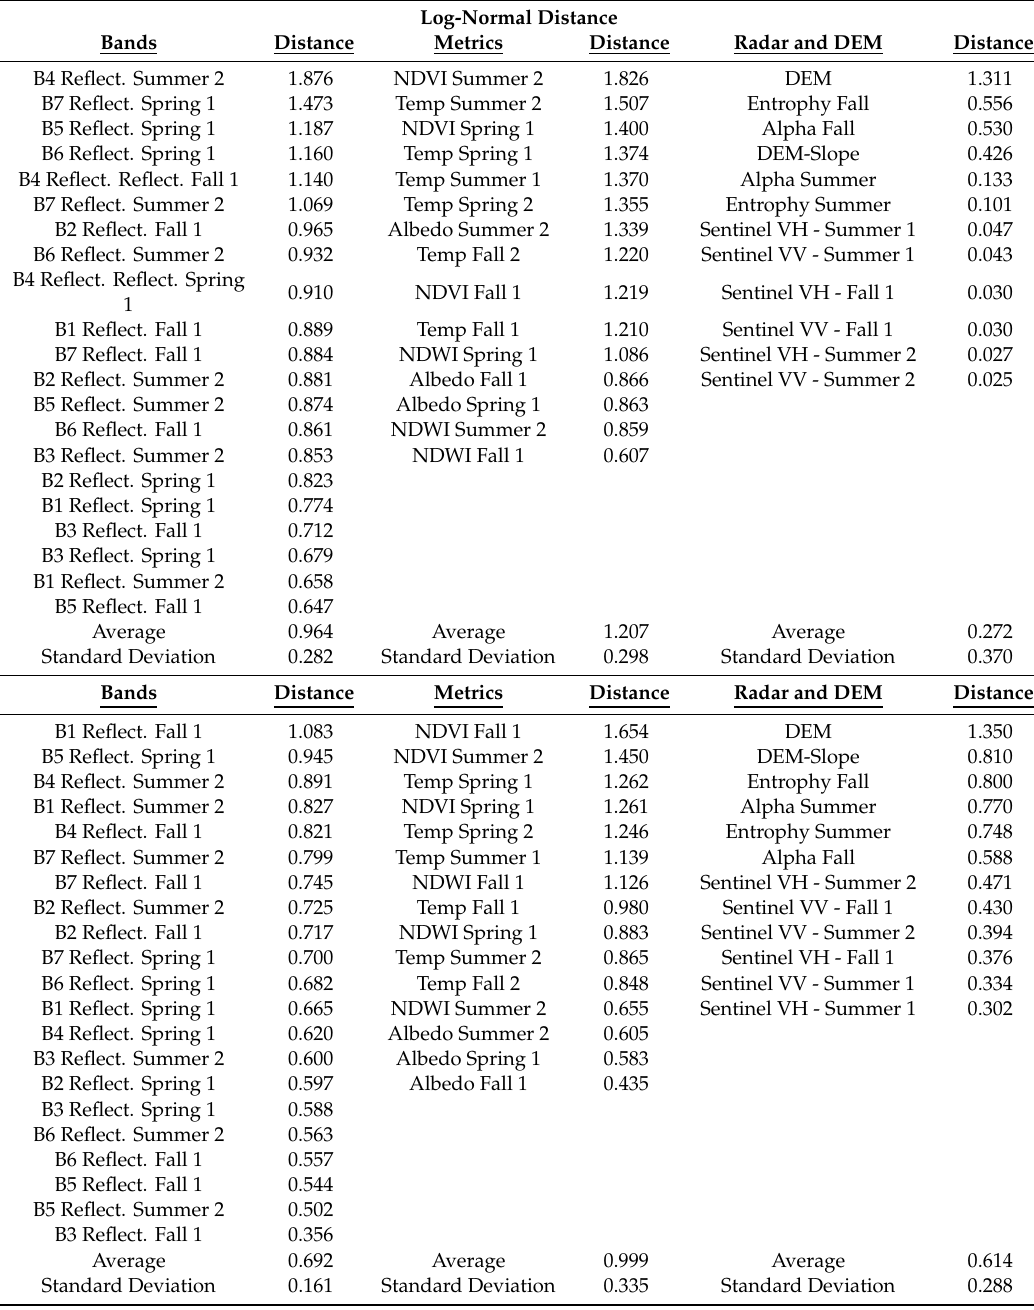
Table 4. (Top) Summary of image feature quality analysis averaged over all land cover types. Image metrics, image bands, radar parameters, DEM and slope sorted from largest to smallest log-normal distance, with a longer distance implying a higher quality. (Bottom) Summary of image feature importance values computed through and averaged over 47 unique RF